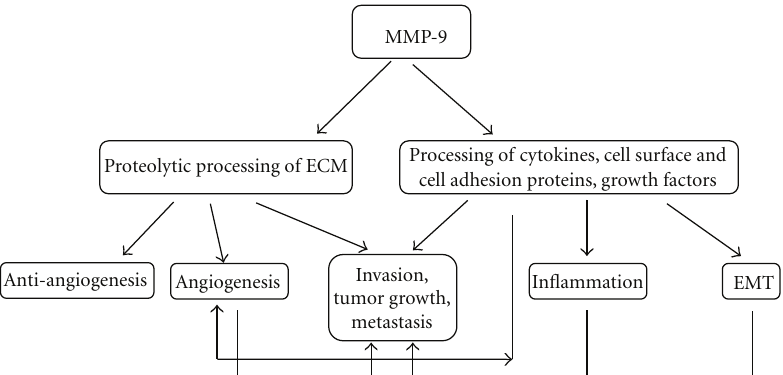
F 2: Schematic picture of the events that are modulated by MMP-9 in oral cancer. Proteolytic degradation of ECM components (including types III, IV, and V collagens, as well as gelatin) by MMP-9 facilitates carcinoma cell invasion and leads to the release of growth factors, such as VEGF, that enhance angiogenesis and tumor progression. At the same time anti-antiangiogenic endostatin, angiostatin, and tumstatin are released. Processing of proin�ammatory chemokines (C�CL1, -4, -8, -9, -11, -12), proforms of cytokines (proTNF- ), cell adhesion proteins such as intercellular adhesion molecule-1 triggers an in�ammatory reaction and modulates transcription factors leading to an epithelial-to-mesenchymal transition and enhanced